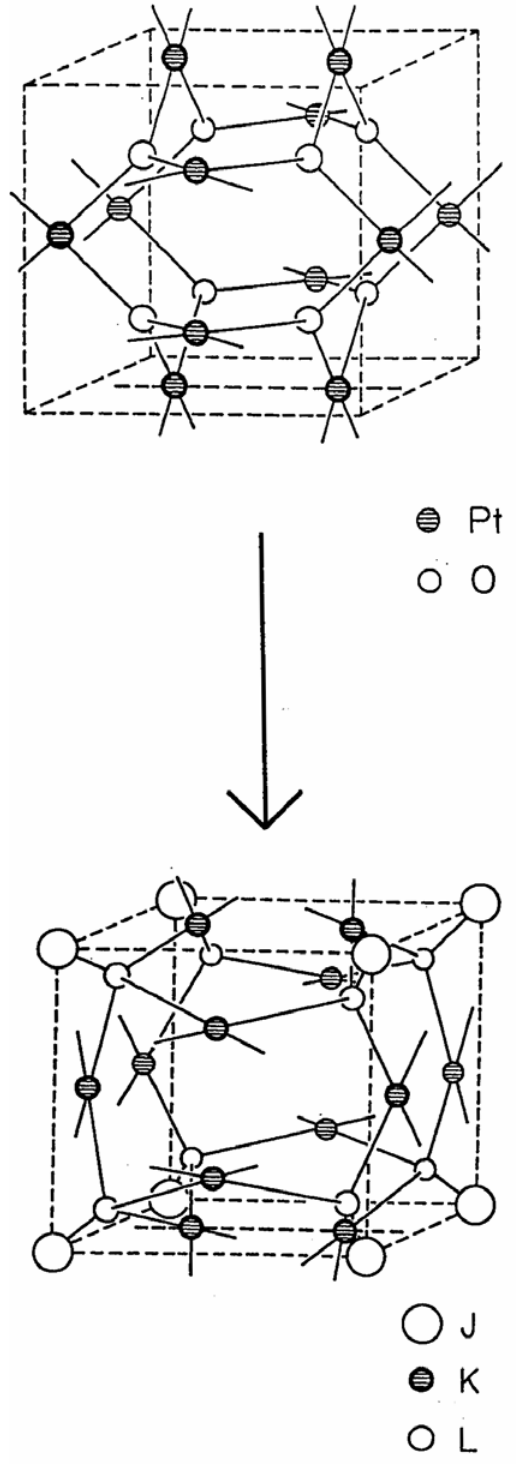
Figure 4. Continuous structural transformation of waserite to